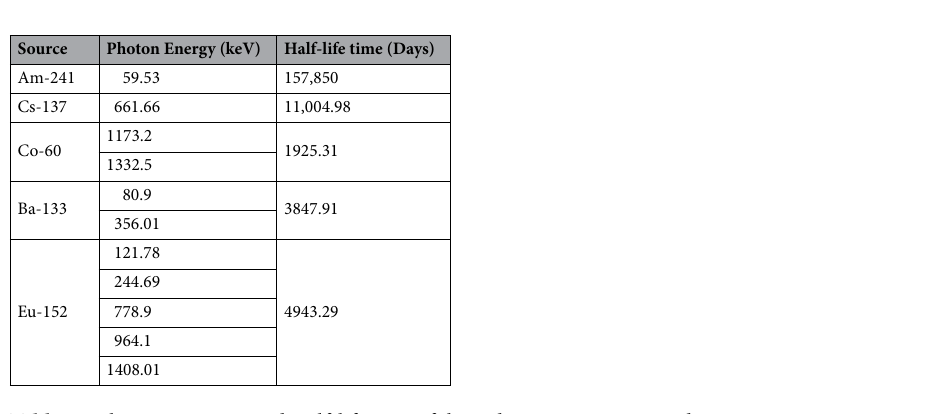
Table 1. Photon energies, and Half-life time of the radioactive sources used.